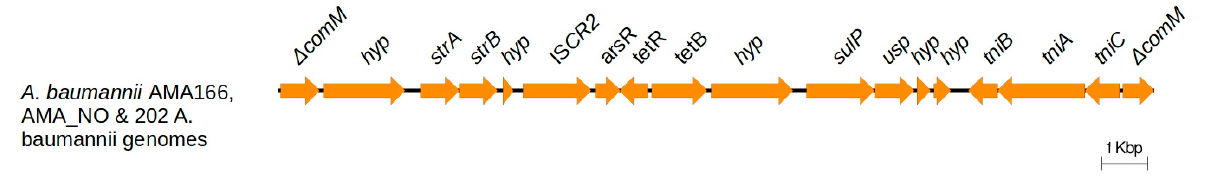
Figure 3. Genetic structure of Tn AbaR genomic island present in A. baumannii AMA_NO and AMA166. An identical genomic island was present in both strains. Figure 3 is deposited in GitHub Repository (https://github.com/germant13/Traglia2023_AbST2_SARS.git (accessed on 9 February 2023). Table 2. Antibiotic susceptibility in A. baumannii AMA 166 and AMA_NO. Diameters of Inhibition Zones (mm)/Minimum